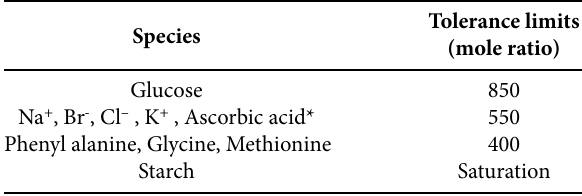
Table 2. Interference study for analysis of 50 μmol L –1 6-TG